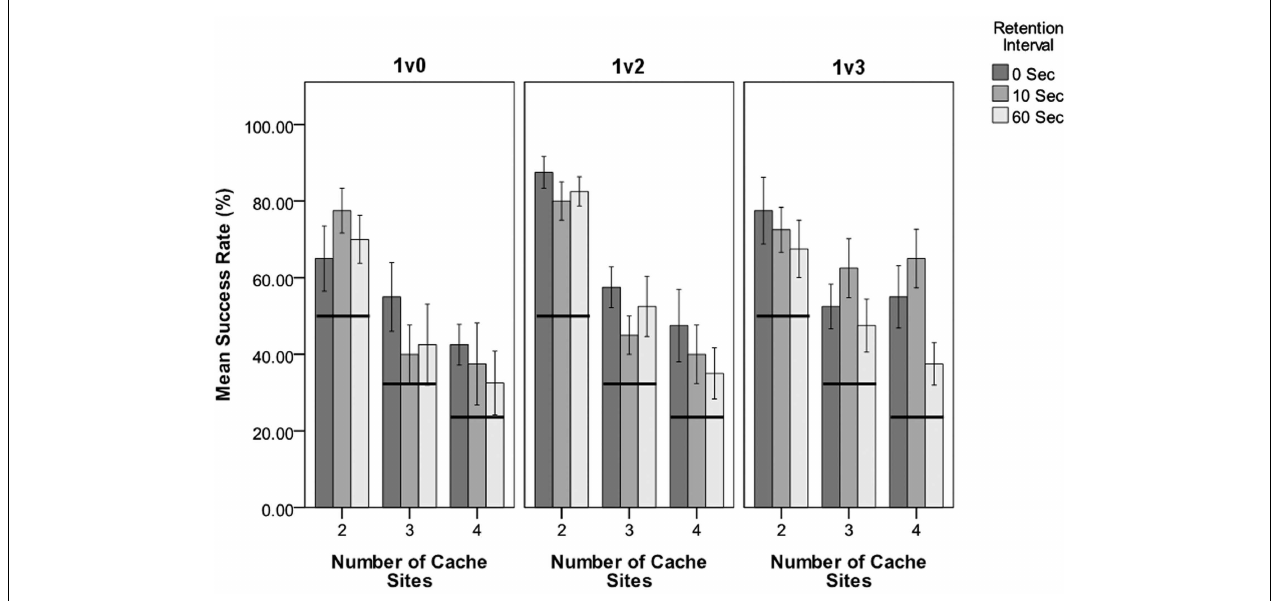
FIGURE 2 |The success rate for each combination of independent variables for the three conditions. Y -axis shows the success rate as a percentage of “correct” choices (i.e., where the largest number of mealworms was selected). X- axis shows number of cache sites with bars grouped according to retention interval (0, 10, and 60s). Indicates the percentage of successes expected by chance for each cache level. Error bars ± 1 standard